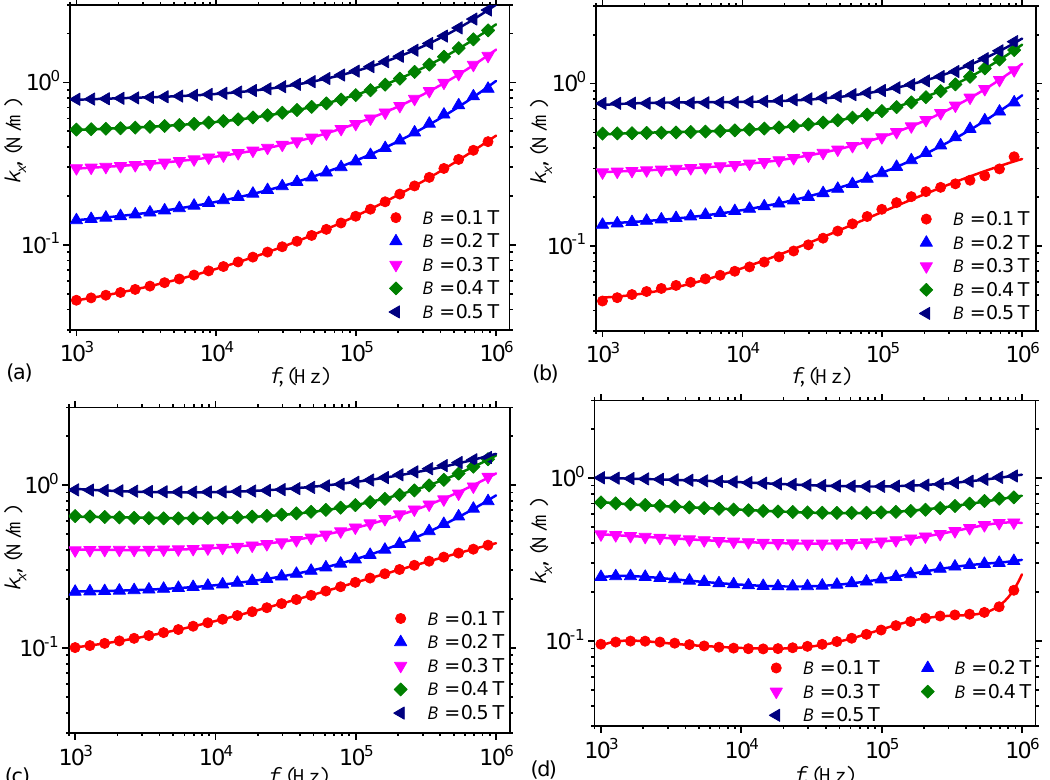
Figure A1. Variation of magneto-electric coupling k x with frequency f , at fixed values of magnetic flux density B . ( a ) hMAC. ( b ) hEMAC 1 . ( c ) hEMAC 2 . ( d ) hEMAC 3